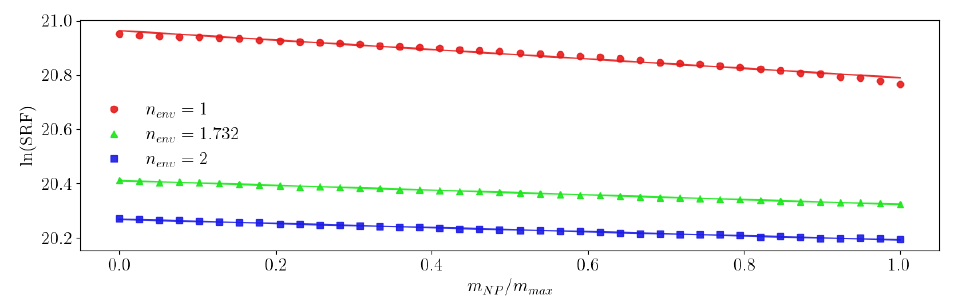
Figure 9. Dependence of the ln ( SRF ) on the ratio m NP / m max for several environment refraction indexes. The solid lines are their fitness to our model (12).